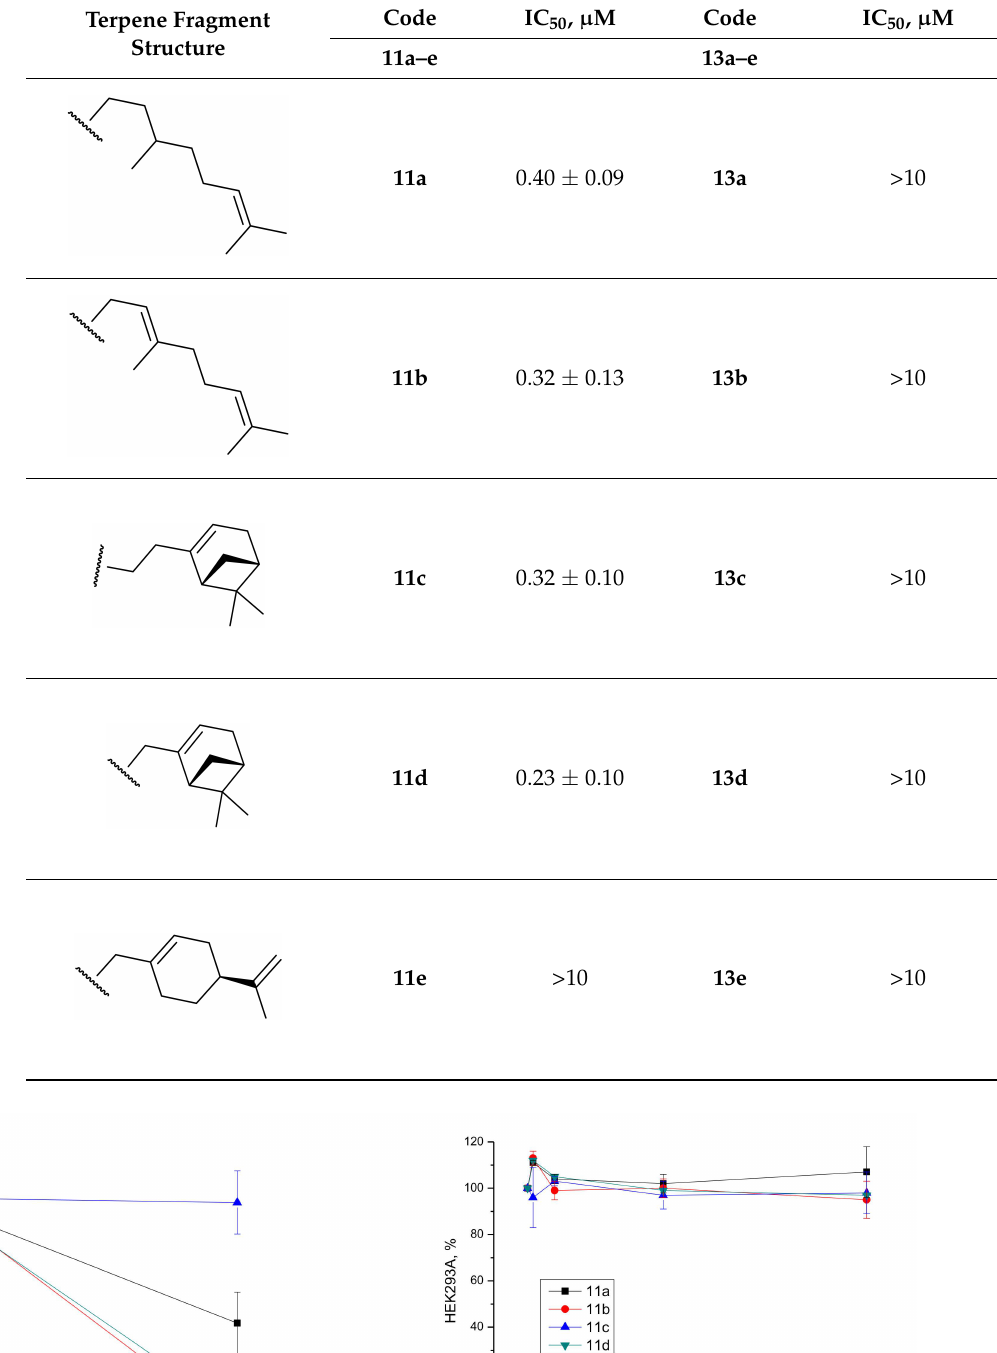
Table 5. The influence of UA derivatives 11a – e and 13a – e on TDP1 activity.